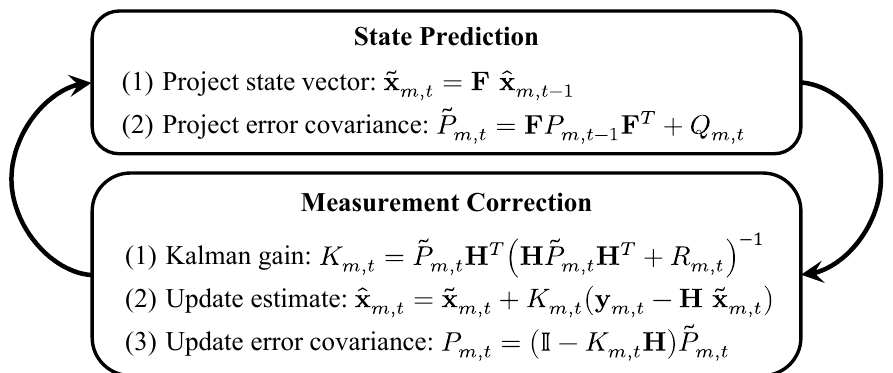
Figure 5. The linear Kalman filter process is comprised of two stages; state prediction and measure- ment